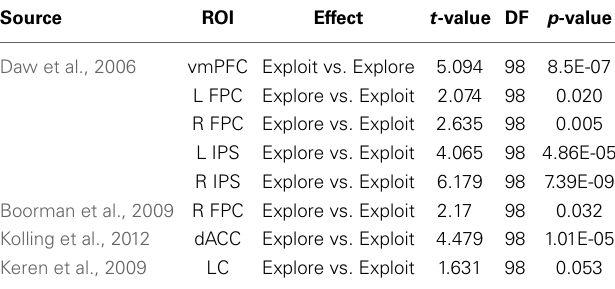
Table 4 | Regions-of-Interest analyses in independent